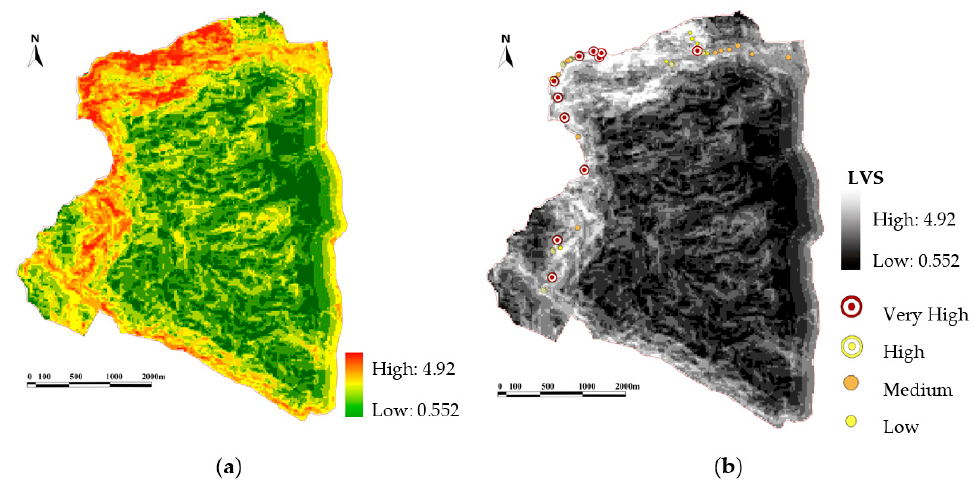
Figure 4. ( a ) Landscape visual sensitivity of Tianmeng Mountain Scenic Spot. ( b ) The combined performance of LVS and LAE in Tianmeng Mountain Scenic Spot.